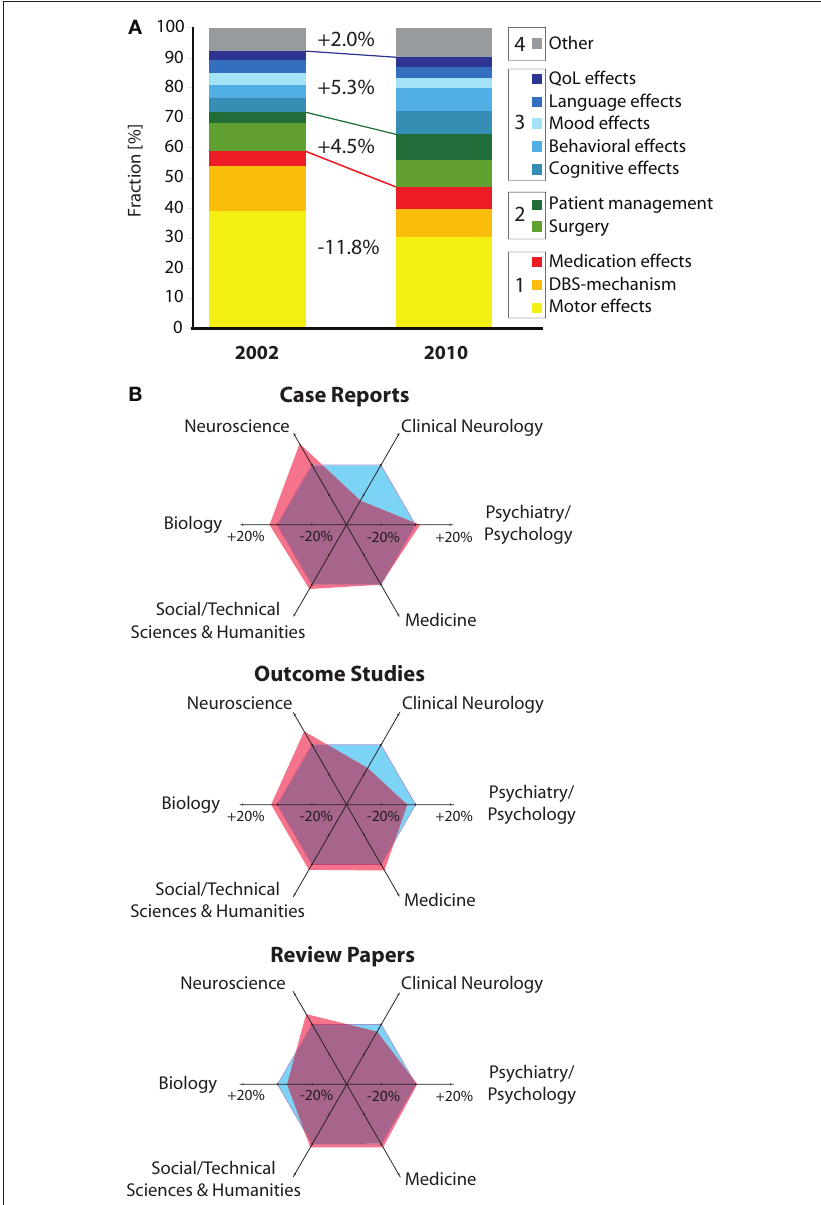
FIgure 1 | (A) Change of the relative weight of issues discussed in the DBS community based on an analysis of the posters published in 2002 and 2010 on the International Congress of Parkinson’s Disease and Movement Disorders. The issues are grouped into four classes: 1. Understanding therapeutic effects, 2. Medical intervention issues, 3. Affective, behavioral, and cognitive side effects of DBS, 4. Other issues. (B) Impact analysis for three types of DBS literature: case reports, outcome studies, and review papers. The blue hexagon is the reference (percentage of publications equals percentage of citations in each cluster), whereas the red polygon shows the actual fraction of citations minus the fraction of publications for each